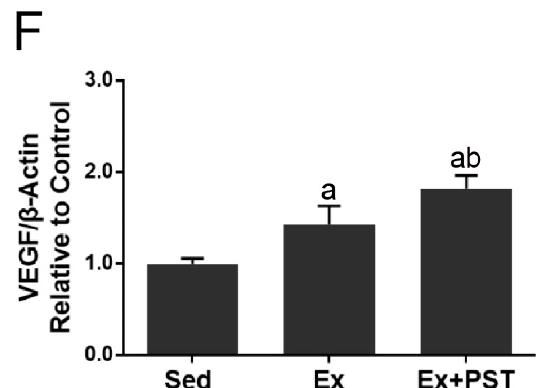
Figure 3. Effects of pterostilbene (PST) supplementation on muscular angiogenesis in exercise training rats. Paraffin sections were obtained from soleus muscles and stained for CD31 (a marker of endothelial cells) (200 × objective) ( A ). Capillary to fiber ratio ( B ) and vascular density ( C ) were determined by counting the CD31+ vascular structures from three independent fields of view per animal. Genes expressions ( D ), representative western blotting bands ( E ) and their quantitative analysis ( F ) of VEGF from soleus. Scale bar, 100 μ m. Protein expression levels were normalized to the expression of β -actin. Data are expressed as mean ± SD, a— p < 0.05 compared with Sed group; b— p < 0.05 compared with Ex group.